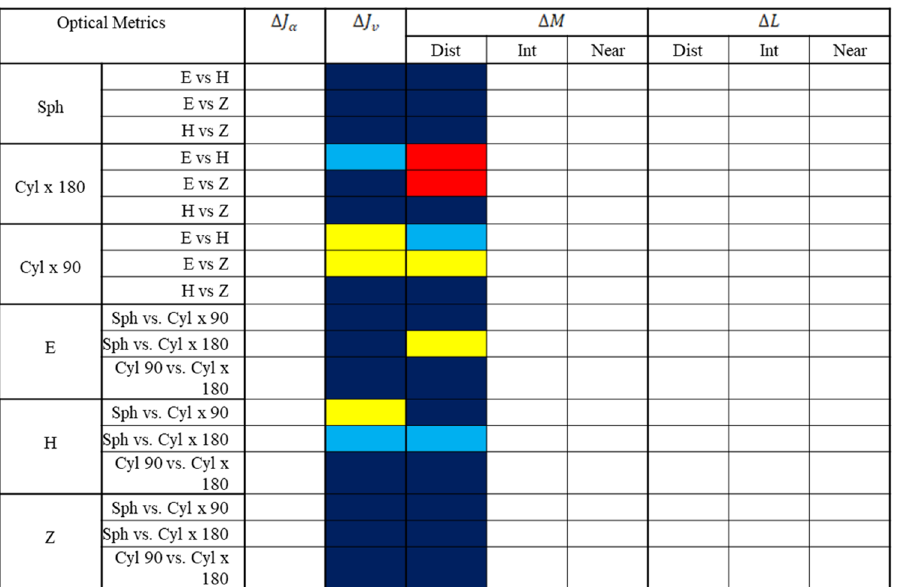
Table 2. Summary of two-way ANOVA results for different metrics. This statistical summary indicates the level of significance obtained with various metrics for the different manufacturers and prescriptions. The color code of the p-value is as follows: dark blue, p > 0.05 (not significant); light blue, p 0.001. Note that the blank field corresponds to the conditions where the statistical test is not applicable (i.e., ≤ presence of interaction between prescription and manufacturer, or absence of a significant main effect). H Hoya, E Essilor, Z Zeiss.